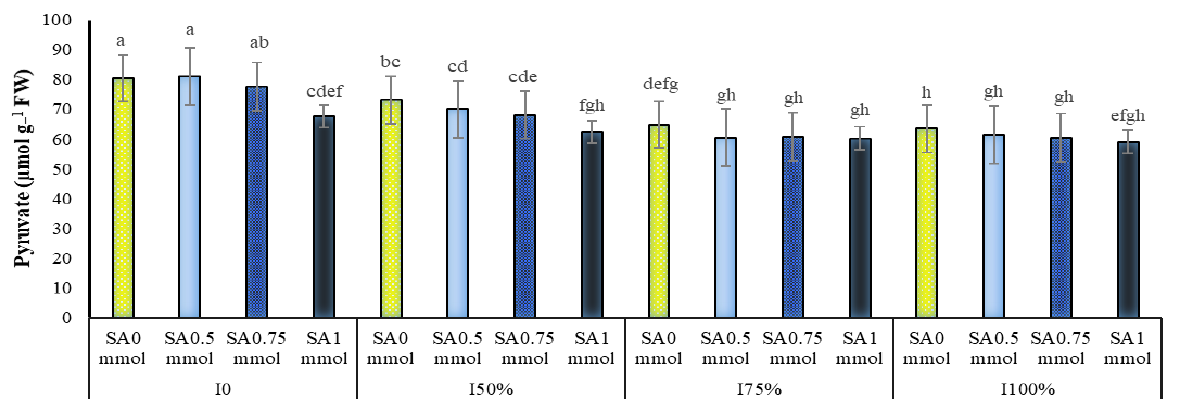
Figure 9. Dual interaction of different levels of irrigation (I0 = no irrigation, I50% = 50%, I75% = 75% and I100% = 100% water requirement of the plant) and salicylic acid application concentrations (SA0 = non-application, SA0.5 = 0.5 mmol, SA0.75 = 0.75 mmol and SA1 = 1 mmol) on the amount of pyruvate (sharpness) of A. hirtifolium . Columns designated by the same letter are not significantly different at the p ≤ 0.05 level as determined by the LSD test.